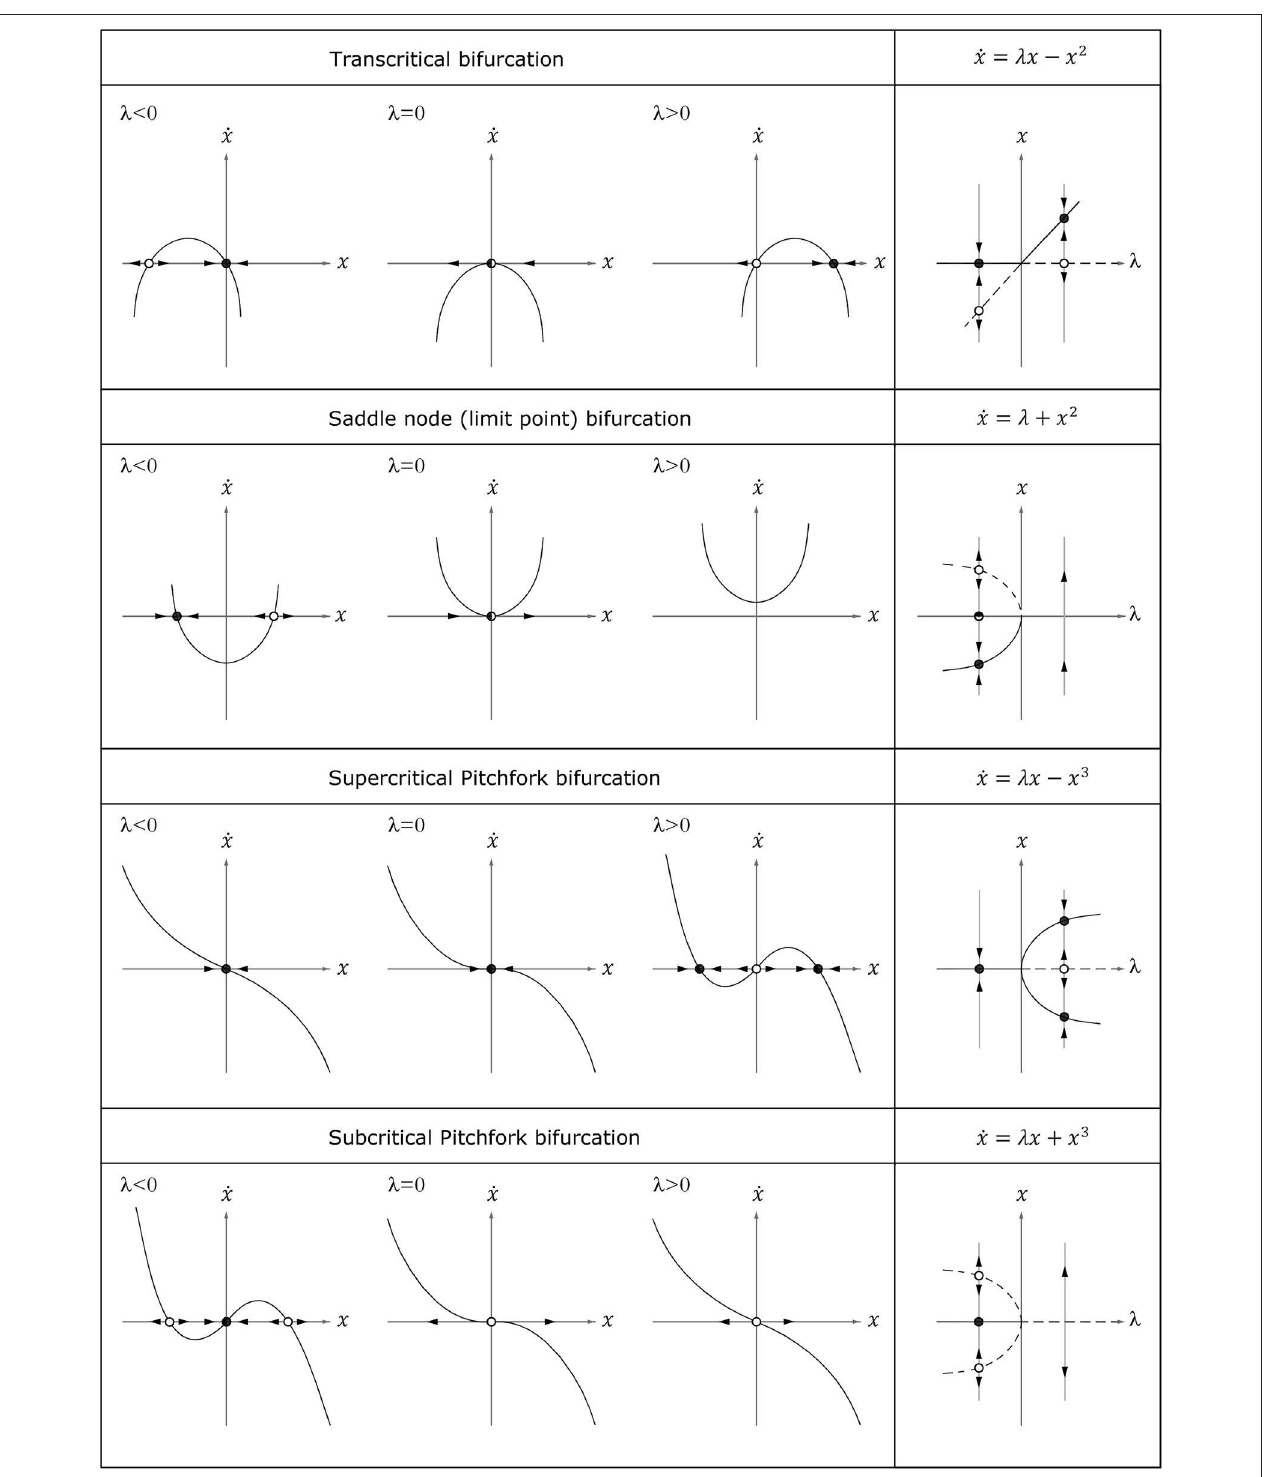
FIGURE 3 | Phase portrait evolution by changing the parameter λ (left) and bifurcation diagram corresponding to the normal form (right) .